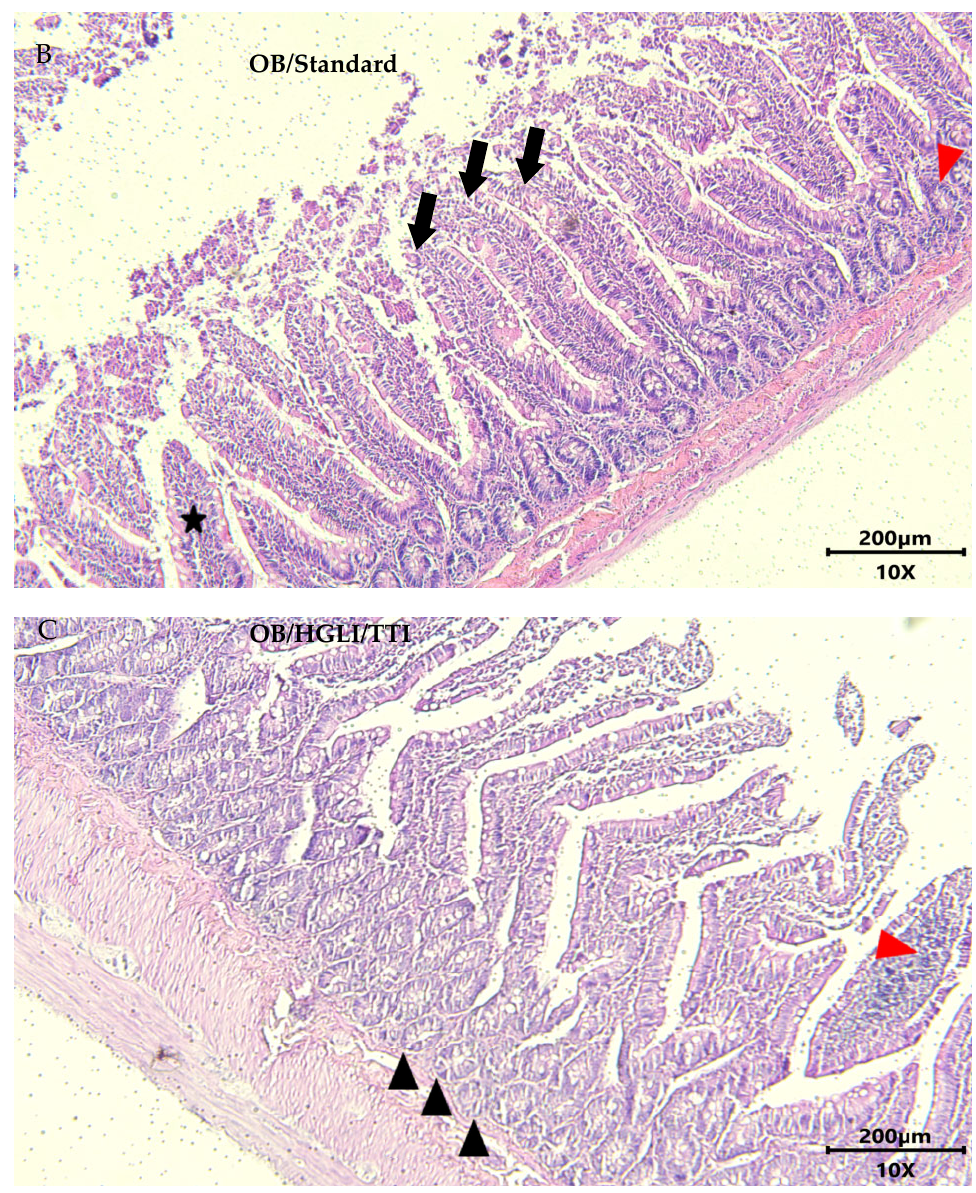
Figure 10. Histological slides representative of the small intestine of Wistar rats with obesity induced by HGLI diet, after ten days of experiment, stained with hematoxylin ‐ eosin. ( A ) Group without treatment (OB/HGLI). ( B ) Group treated with a nutritionally adequate diet (standard diet Labina ® ) (OB/Standard). ( C ) Group treated with the trypsin inhibitor isolated from tamarind seeds (TTI) (OB/HGLI/TTI). Scale bar: 200 μ m. Objective Lens: 10x. Total Magnification: 100×. Signals point to intact villus (star), ulcerated villus (arrow), areas of mononuclear inflammatory infiltrate (red arrowhead), necrotic villus (double arrow), and intact intestinal gland (black arrowhead). OB: obesity; HGLI: high glycemic index and high glycemic load diet.